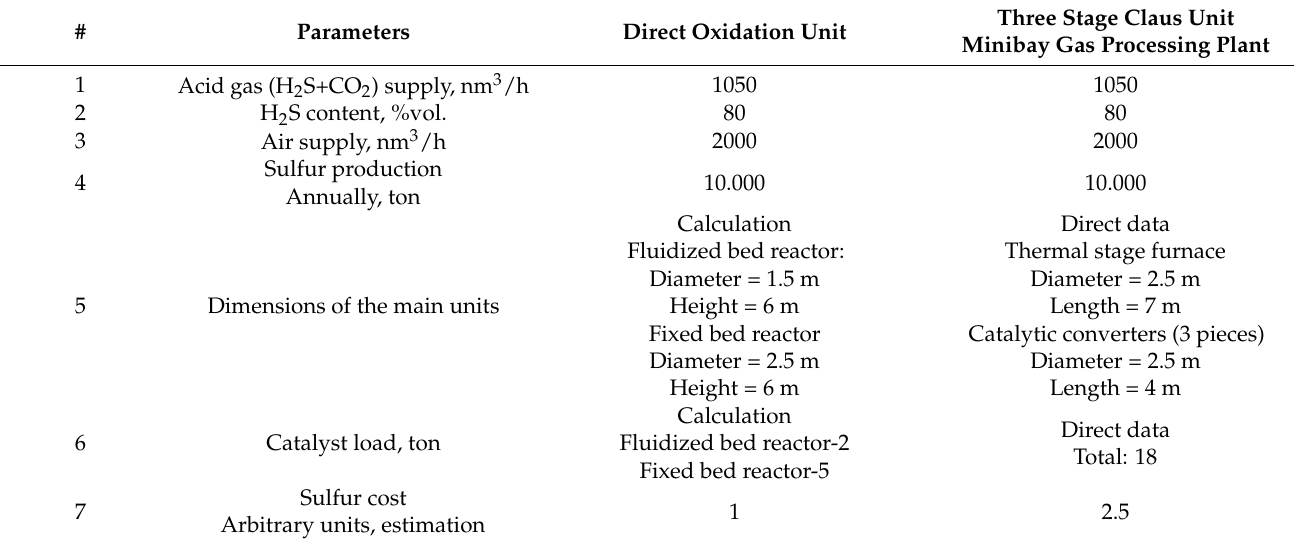
Table 6. Comparison of the characteristics of the Claus Pant and a direct oxidation plant with the same capacities [163,164].